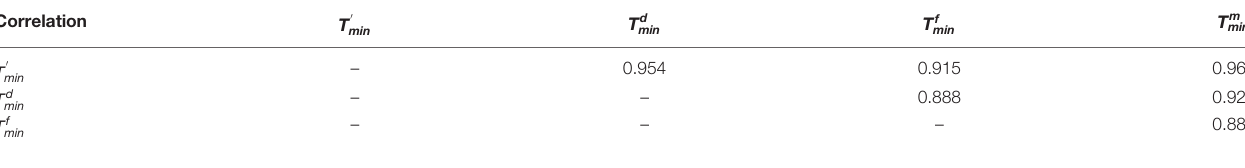
TABLE 2 | Correlation between the transit time indices from all years (the mean, median, most frequent value and minimum, of the “ minimum connectivity time ” : T 0 min , T d min , and T f min and T m min respectively).